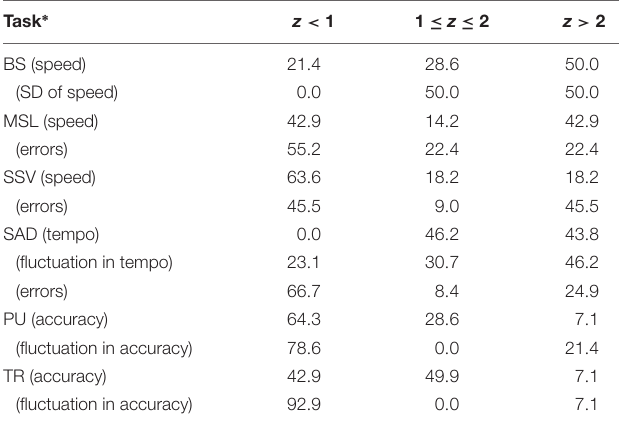
TABLE 3 | Percentage of survivors deviating from the norm per